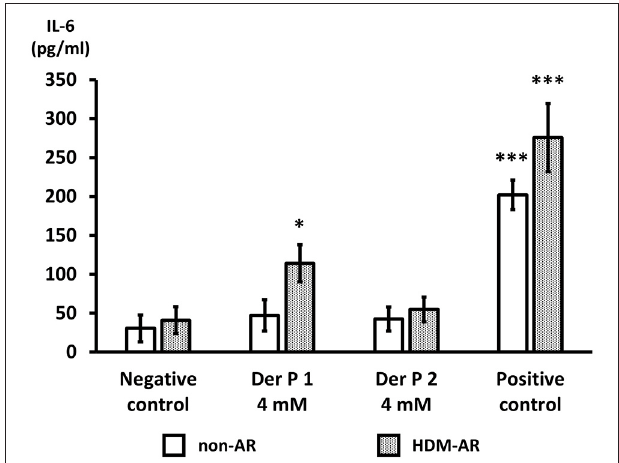
FIGURE 4 | Der p 1 exposure induces IL-6 secretion in HNEC-ALI cultures of HDM-AR patients. IL-6 production (pg/ml) after 6-h exposure to PBS (negative control), Der p 1 (4mM), Der p 2 (4mM) and Poly (I:C) LMW (10 µ g/ml) (positive control) to HNEC-ALI cultures from non-AR or HDM-AR patients.